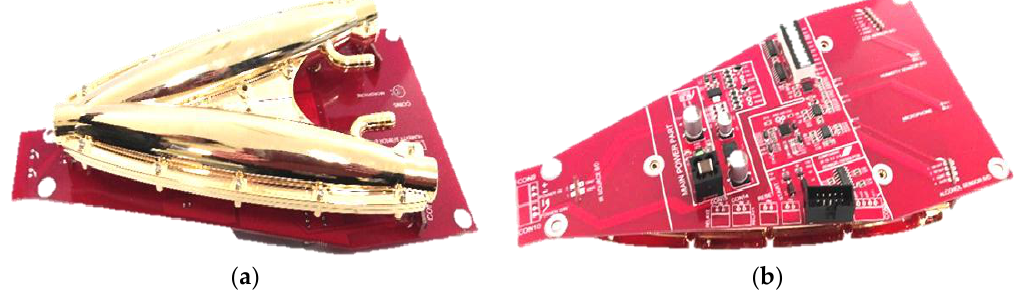
Figure 3. ( a ) Fabricated dual elliptical ethanol sensor module; ( b ) Printed circuit board below the dual elliptical structure.